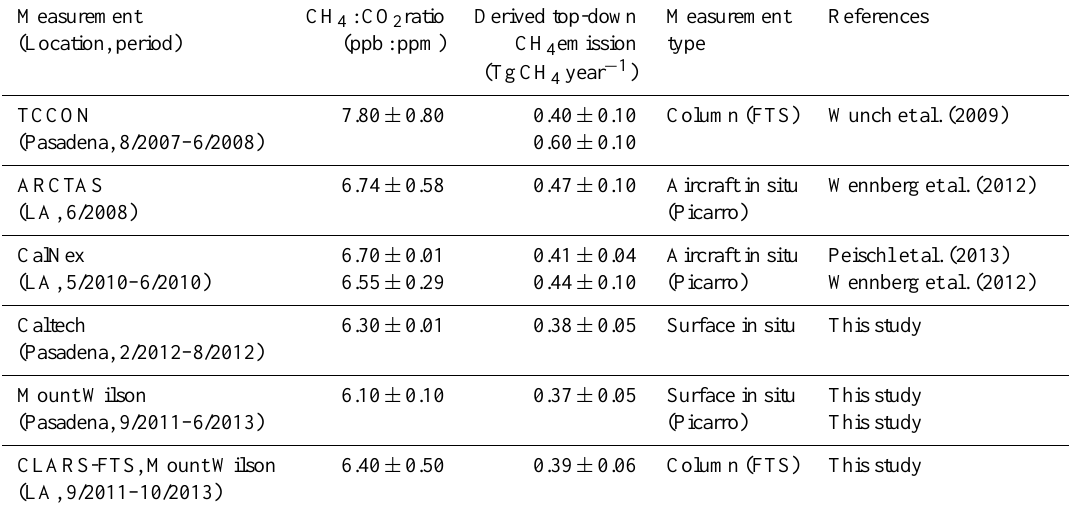
Table 4. Comparisons of CH 4 :CO 2 ratios and derived top-down CH 4 emissions among various measurements in the Los Angeles megacity. Wunch et al. (2009) reported two top-down CH 4 estimates: 0.40 ± 0.10TgCH 4 year − 1 derived from the CH 4 :CO 2 ratio and 0.60 ± 0.10TgCH 4 year − 1 derived from the CH 4 :CO ratio. Please note that it is difficult to compare the uncertainties due to the different measurement